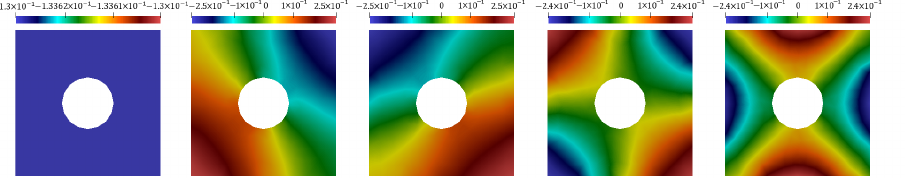
Figure 3. Illustration of the outer boundary multiscale basis functions for Laplace problem, ψ i k = 1, . . . ,5 (from left to right ).